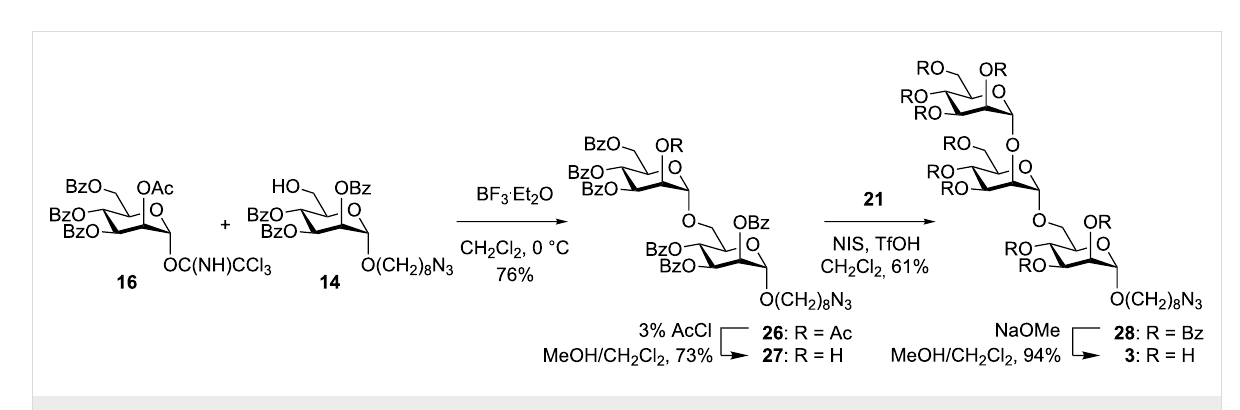
Scheme 4: Synthesis of disaccharide 1 and trisaccharide 2 .